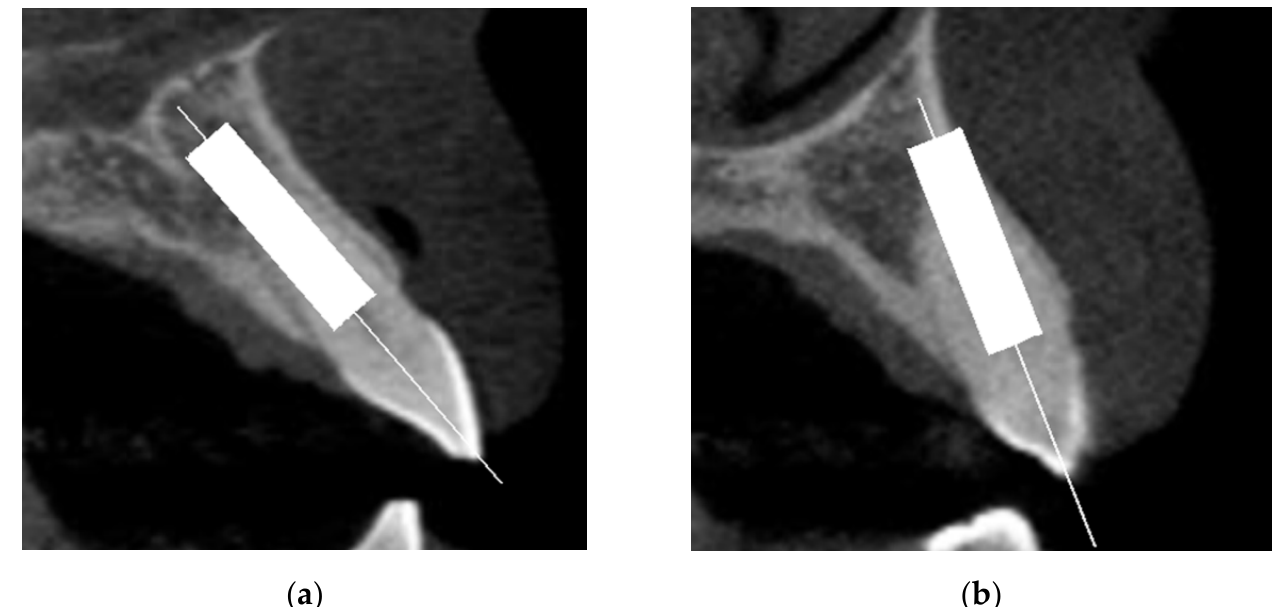
Figure 1. Absence ( a ) and occurrence ( b ) of labial bone plate perforation. 2.6.4. Implant-Line A Angle (ILAA) The angle between the prosthetically-driven ideal position (line A) and the long axis line of the implant in bone-driven position was determined, and defined as the implant-line A angle (ILAA) (Figure 2a).